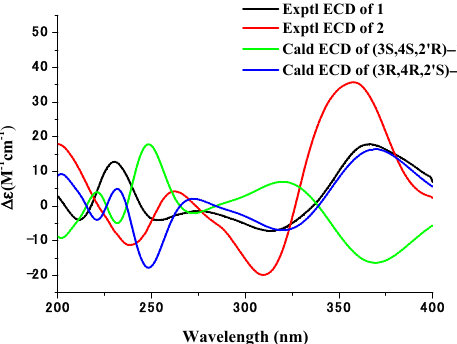
of isomers of 1 .